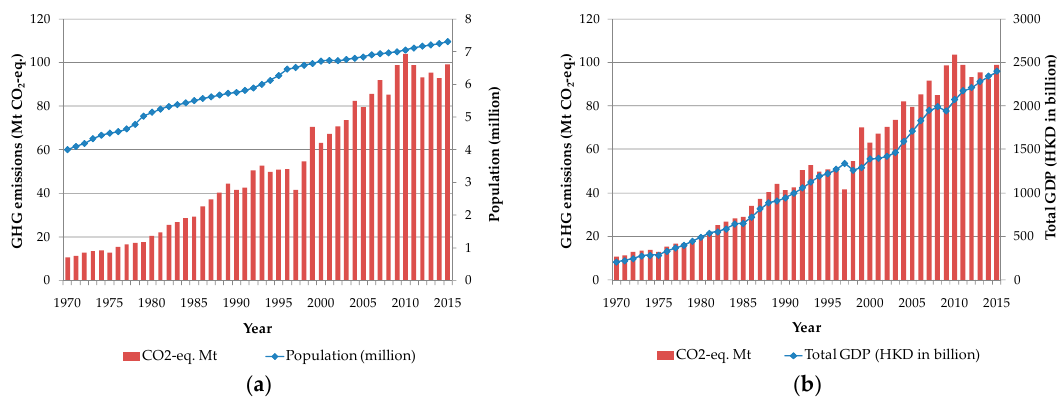
Figure 6. ( a ) GHG emissions and population for the period from 1970 to 2015 (yearly); ( b ) GHG emissions and total GDP for the period from 1970 to 2015 (yearly).